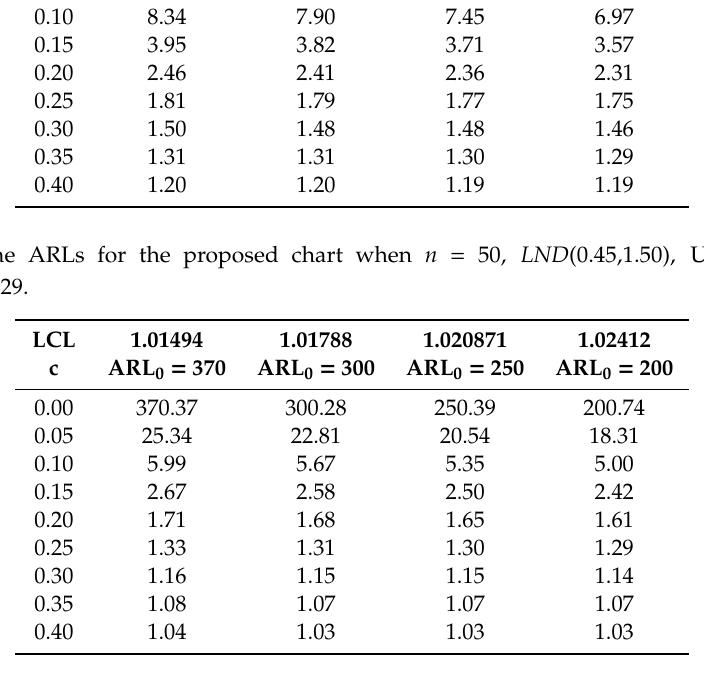
The ARLs for the proposed chart when n = 25, LND (0.50,1.00), USL = 21.6678, and LSL =